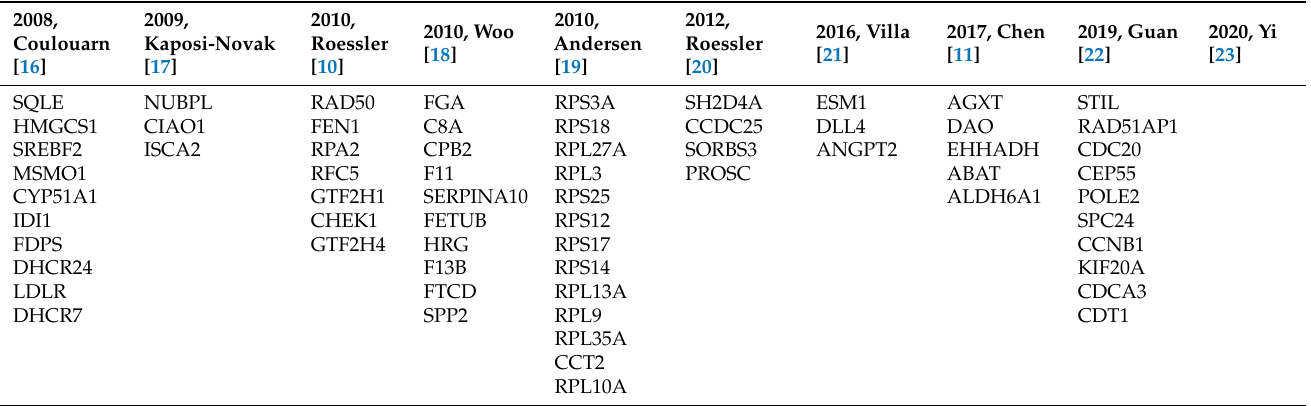
Table 5. Common core genes of HCC gene